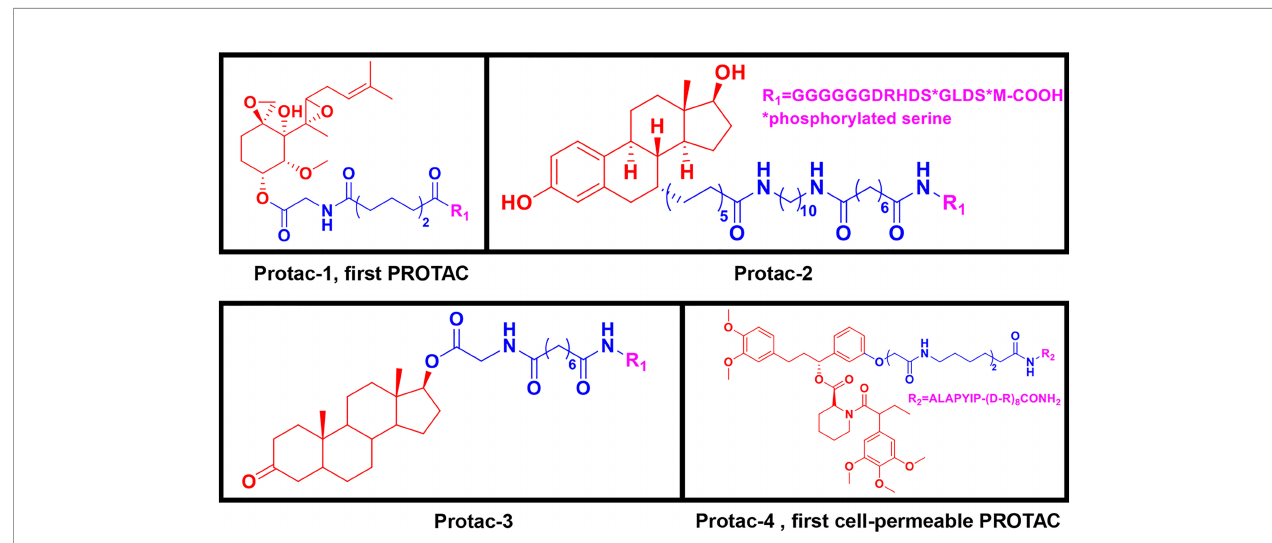
FIGURE 2 | First-generation PROTACs, Peptide-based PROTACs. Chemical structures of Protac-1 ( fi rst PROTAC), Protc-2, Protac-3, and Protac-4 ( fi rst cell- permeable